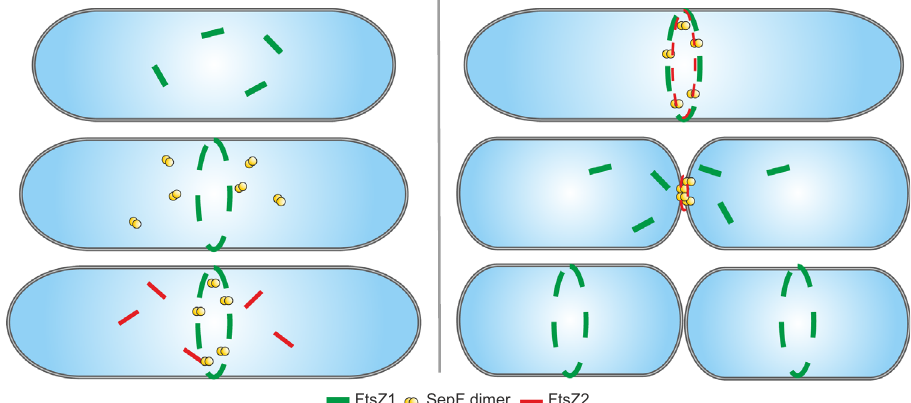
Fig. 10 Model of cell division in H. volcanii . Left: Directly after the last round of cell division FtsZ1 (green) is positioned at the future site of cell division, by a so-far unidenti fi ed mechanism, forming the FtsZ1 ring. Next, SepF dimers (yellow) are localized in an FtsZ1-dependent manner to the site of cell division, and SepF recruits and anchors FtsZ2 (red) to the septum, resulting in the formation of the FtsZ2 ring. Right: After assembly of the mature divisome constriction is initiated either by force generation or incorporation of new cell wall material. From the septum released FtsZ1 proteins then directly localize to the future site of cell